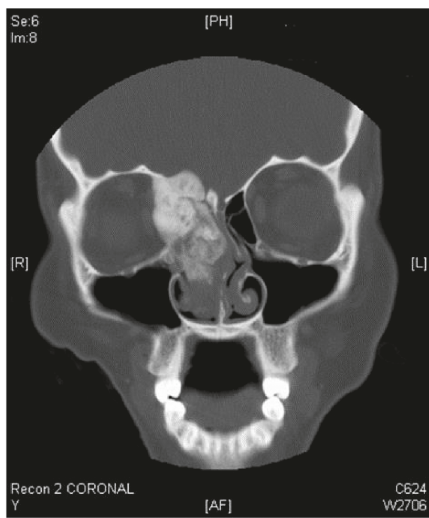
Figure 8: The right ethmoid sinus and nasal space growth encompassing penetration of the orbital as well as cerebral in- terplanetary are perceived preceding the paranasal coronal CT scan image.